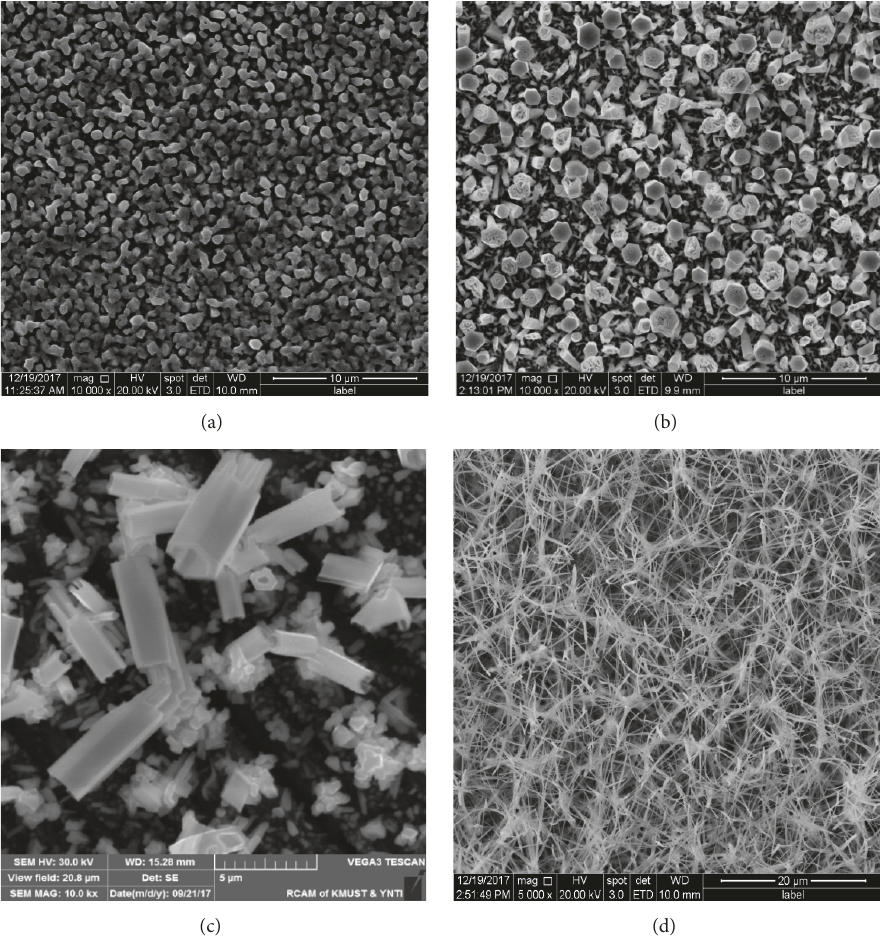
Figure 3: SEM images of Sn deposits obtained on Cu substrates from the SnO-[Bmim]HSO 4 solution with different water concentration: (a) 0% H 2 O, (b) 10% H 2 O, (c) 30% H 2 O, and (d) 50% H 2 O. Deposition temperature: 353K; deposition potential: − 0.6 V (versus